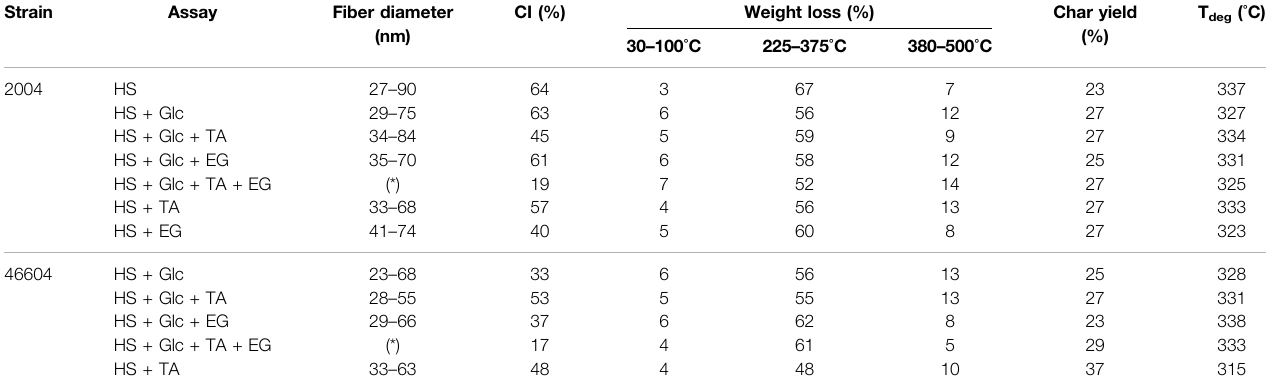
TABLE2| Fiberdiameter,crystallinityindex(CI),weightloss,charyield,anddegradationtemperature(T deg )ofBCgrowninglucose,TA,andEGby K.xylinus DSM2004and DSM 46604.